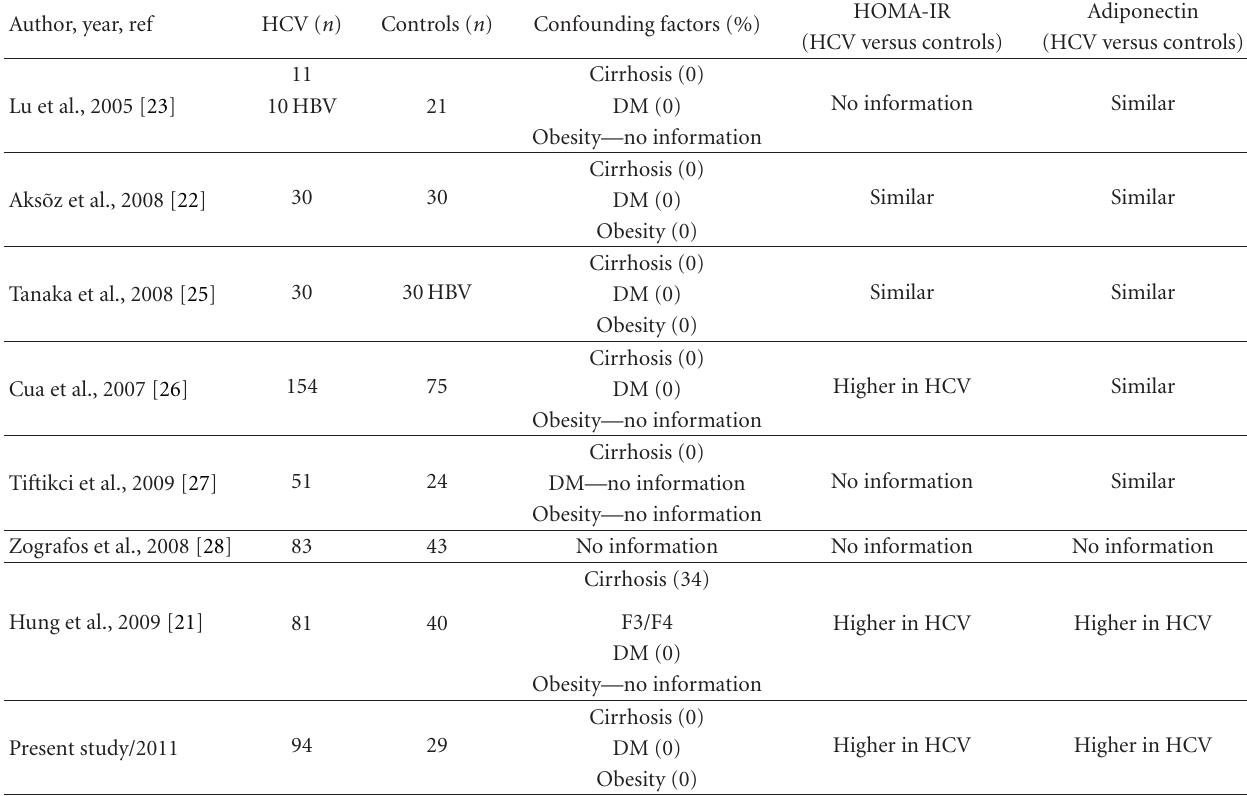
Table 5: Main results of the studies with reference to HCV, IR, and